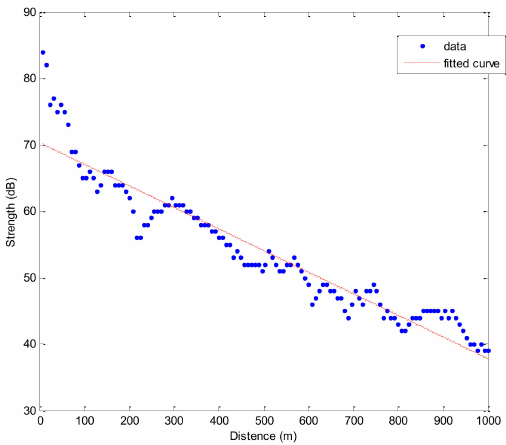
Figure 7. Signal strength varying with distance.